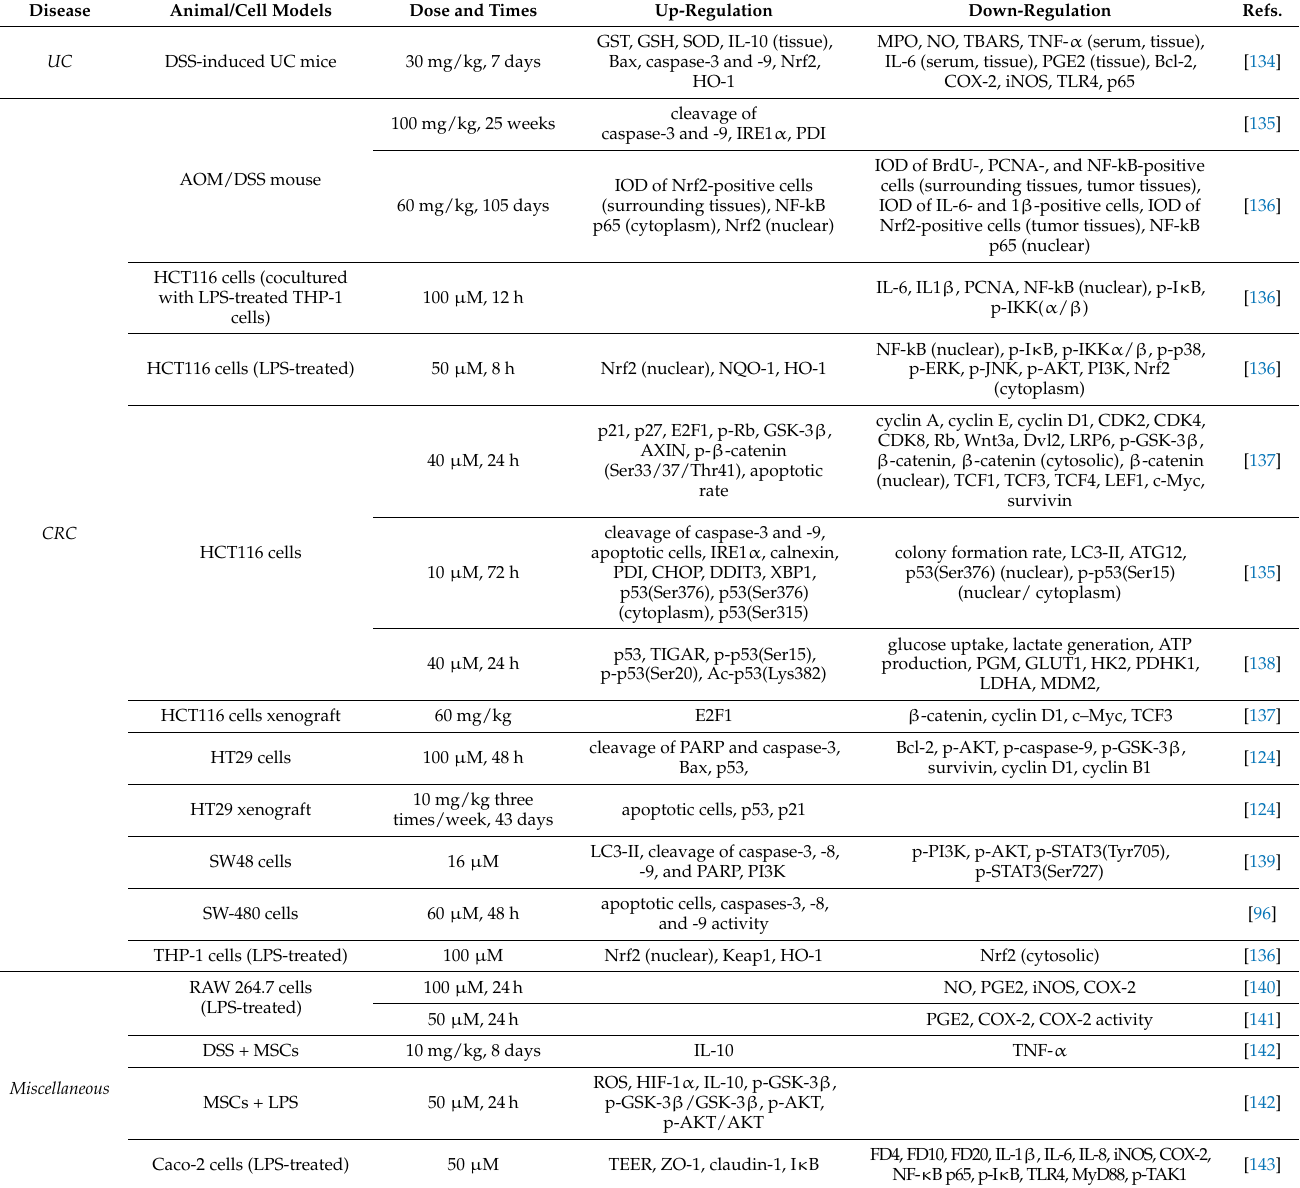
Table 4. The effect of wogonin on inflammatory bowel disease and colorectal